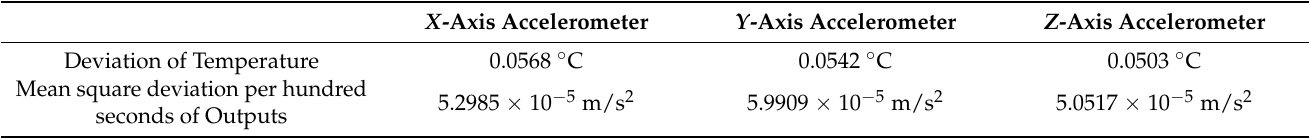
Table 3. The deviation of accelerometer temperature and mean square deviation per hundred seconds of accelerometer outputs.